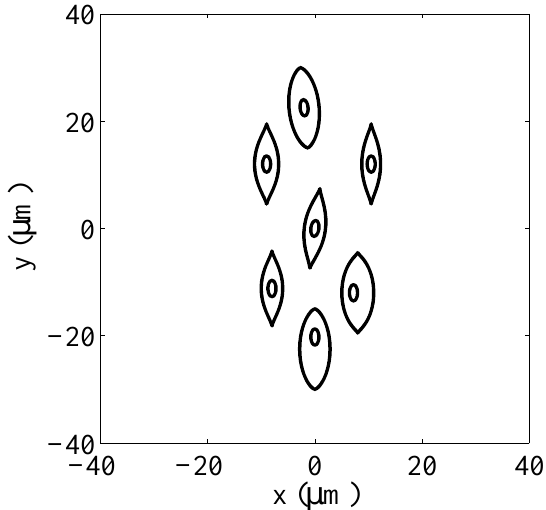
Figure 14. Irregularly shaped multicellular arrangement having more complex physiological